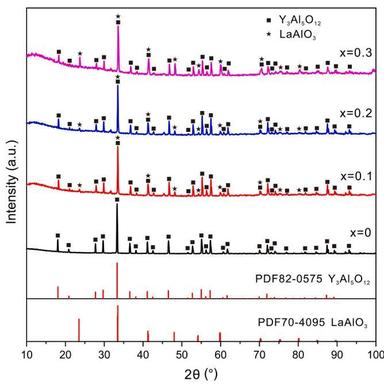
XRD patterns of (Y1-xLax)3Al5O12 (x = 0, 0.1, 0.2, 0.3) samples.